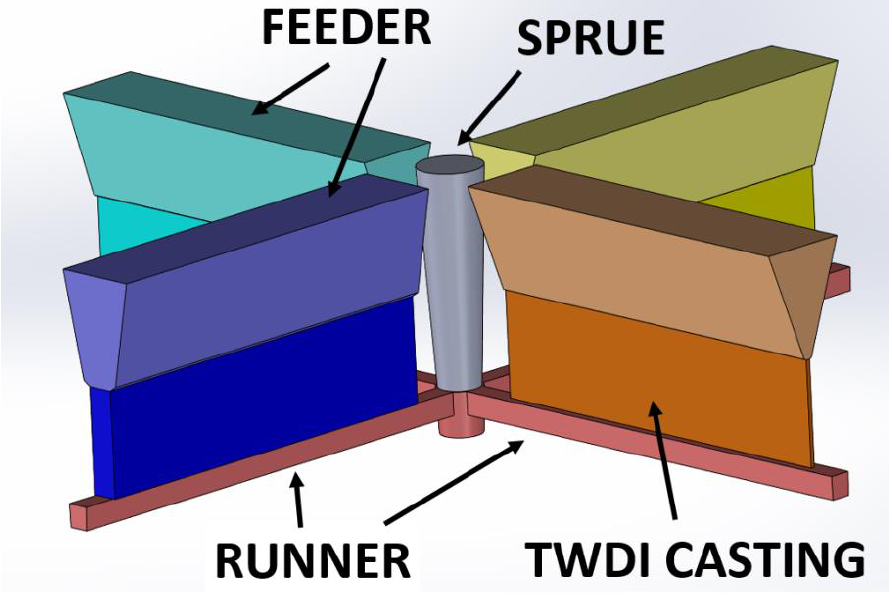
Figure 4. The concept of the 3 layouts of the castings in the mold.